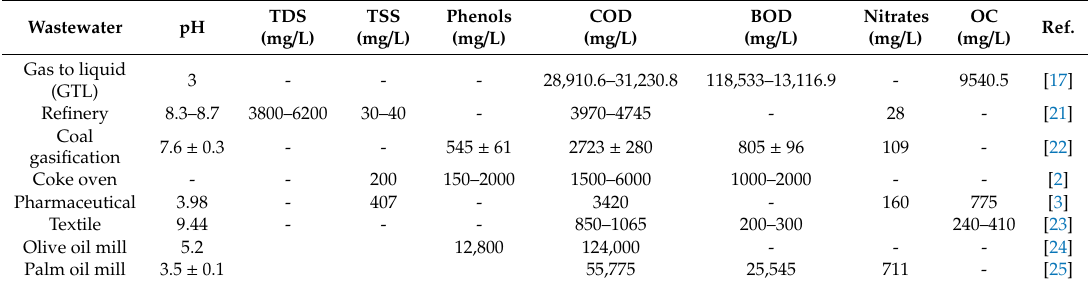
Table 1. The concentrations of major pollutants in di ff erent types of industrial